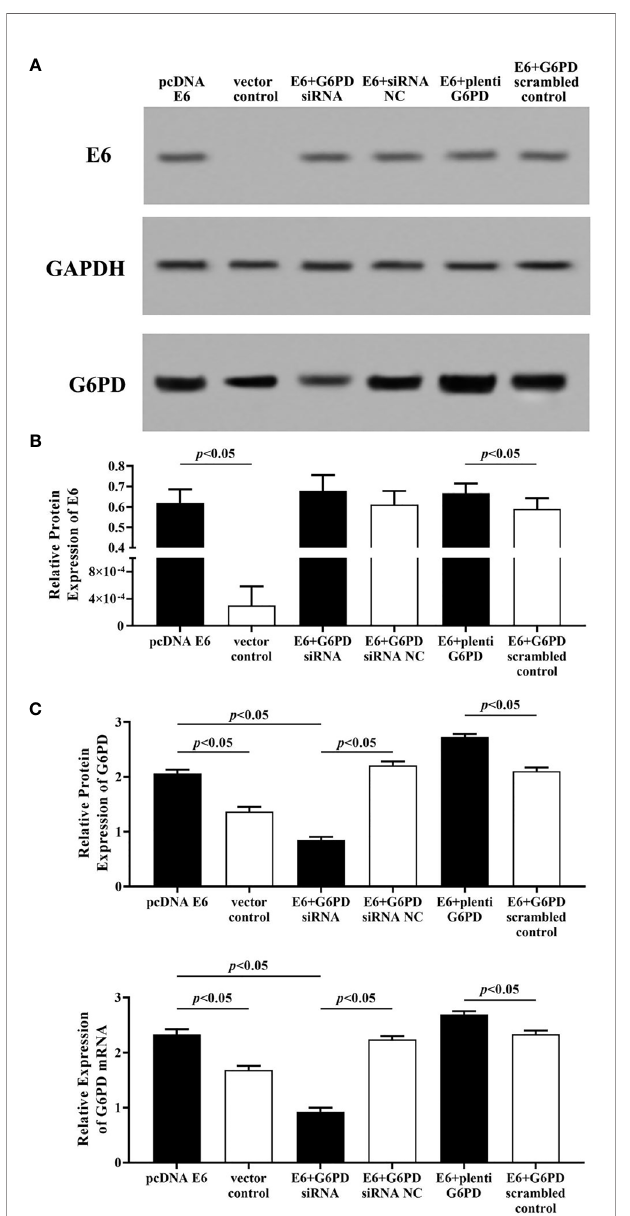
FIGURE 5 | HPV E6 expressional changes regulate the transcriptions and protein levels of G6PD in HeLa cells. The expression levels of E6 protein (A, B) and G6PD protein (A, C) /mRNA (C) were indicated by Western blots and/or RT-qPCR. (A) Representative blots from six groups. Statistical plots of the relative expression of E6 protein (B) , and G6PD protein/mRNA (C) . Data are presented as means ± SD (n = 5). FIGURE 6 | HPV E6 expressional changes regulate the transcriptions and